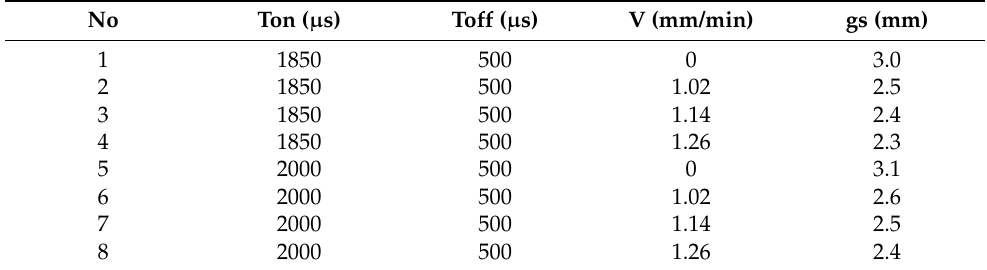
Table 3. Validation experiments.